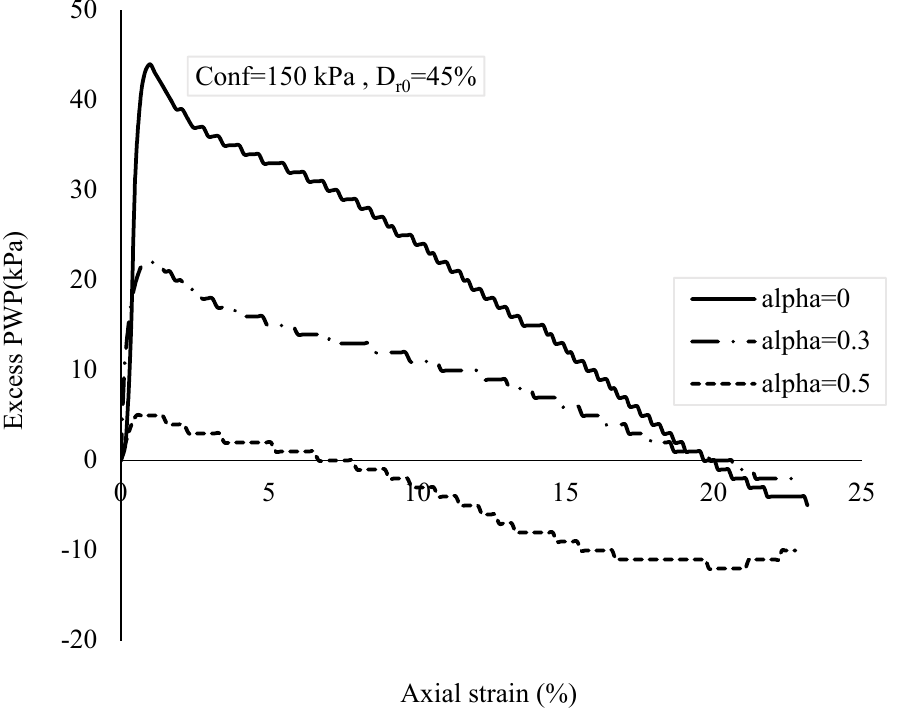
Figure 10. Comparative curvature for (R–A) 3 , (R–B) 3 and (R–C) 3 in the u– ε % plane. Alpha ( α ): the initial shear stress ratio.